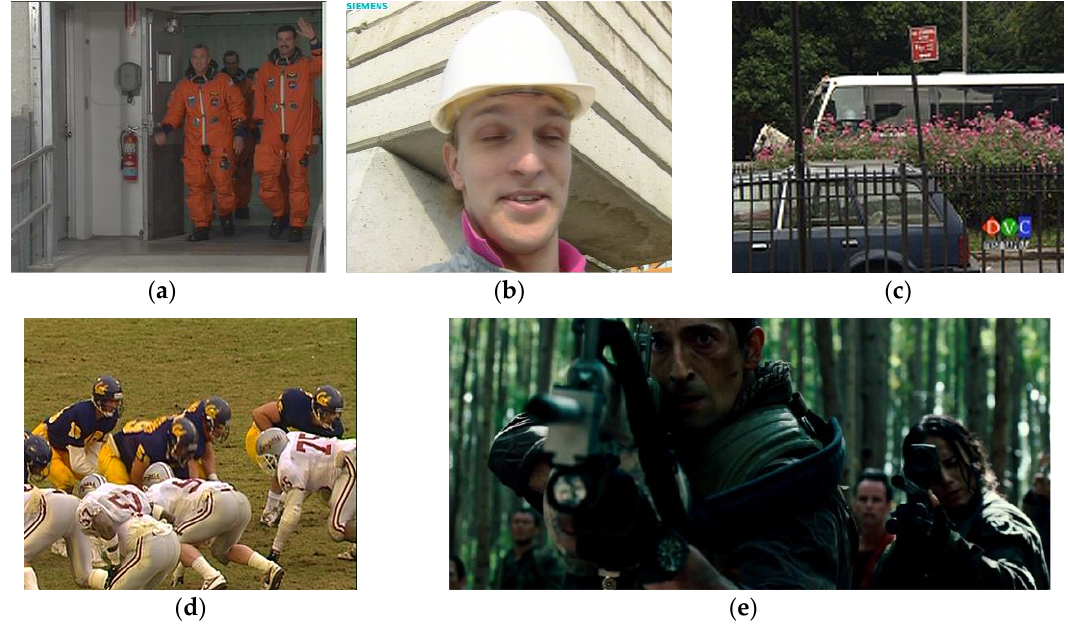
Figure 5. Test video sequences; ( a ) Crew (4CIF@30fps), ( b ) Foreman (CIF@30fps), ( c ) Bus (CIF@30fps), and ( d ) Football (CIF@30fps), and ( e ) movie (1280 × 544@24fps).